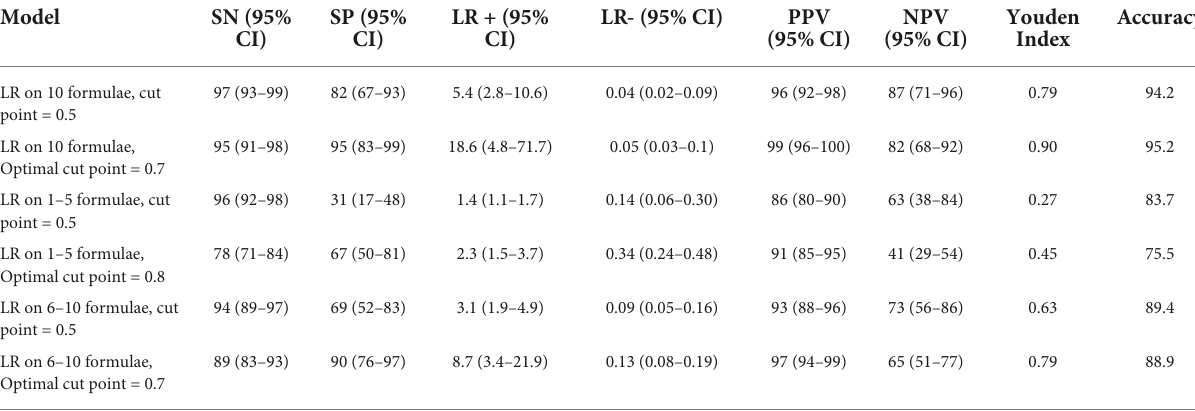
TABLE 3 Diagnostic indices after multiple logistic regression model based on derivation data set. Model